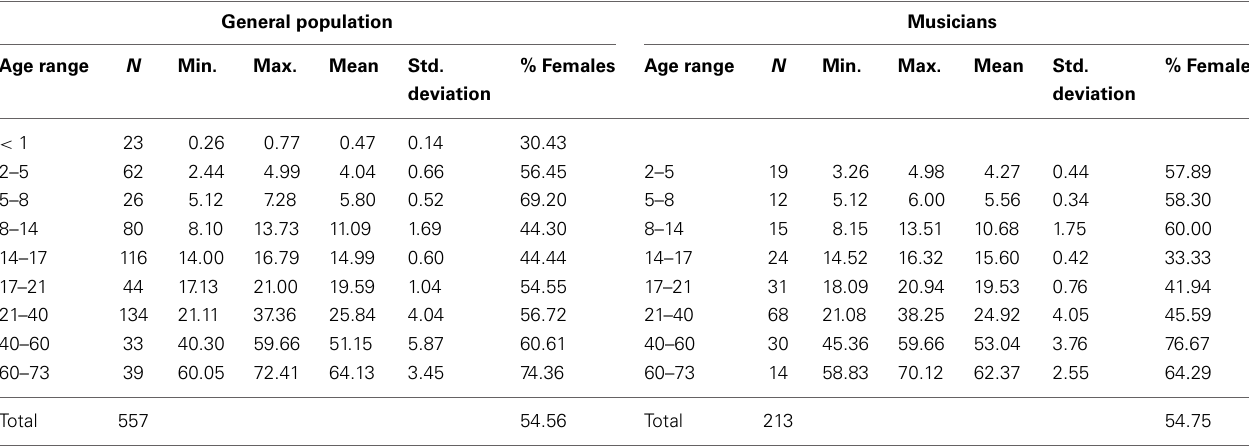
Table 1 | Participant and group